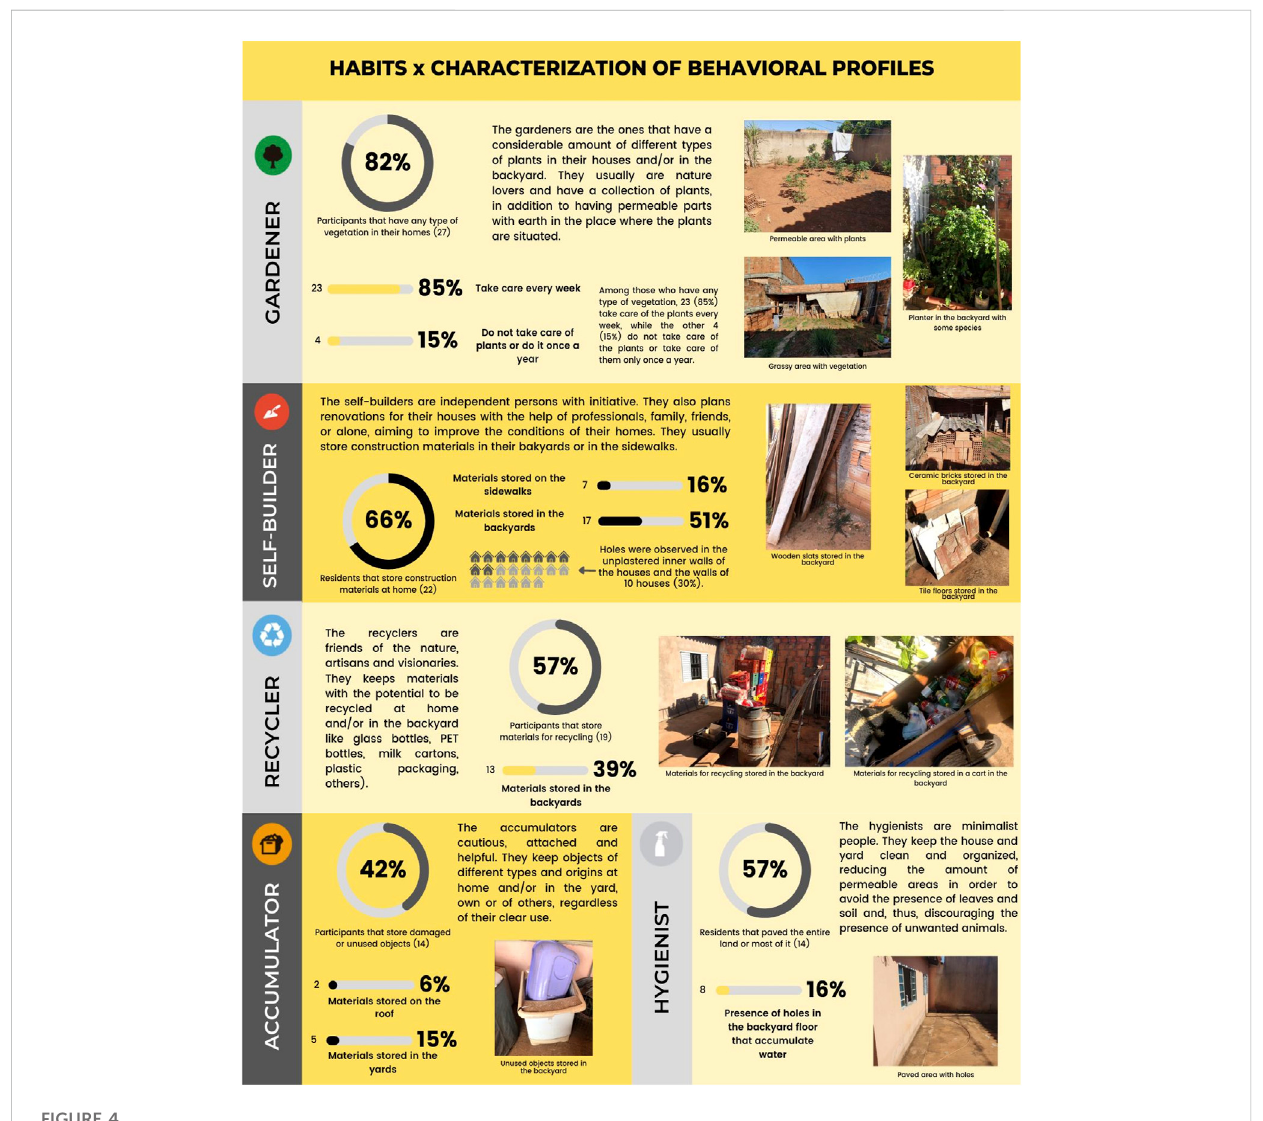
FIGURE 4 Habits x characterization of behavioral pro fi